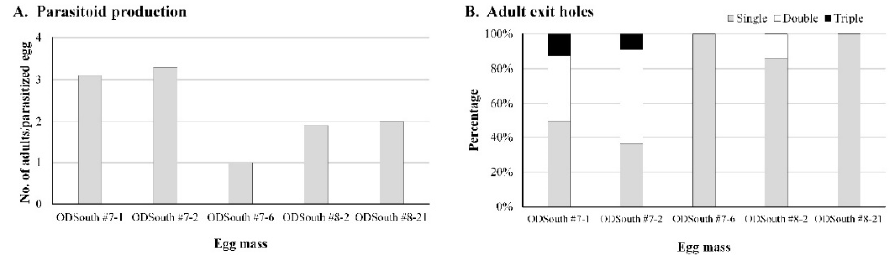
Figure 4. L. delicatula eggs with (A) normal hatching holes on the top and (B) O. kuvanae adult exit holes at the bottom.